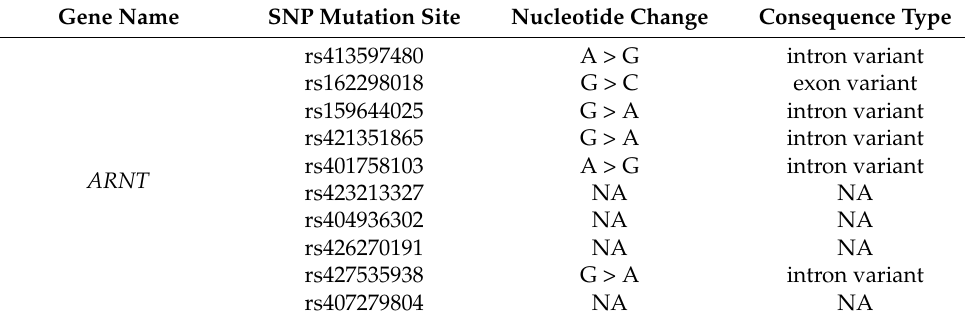
Table 1. SNPs observed in the ARNT